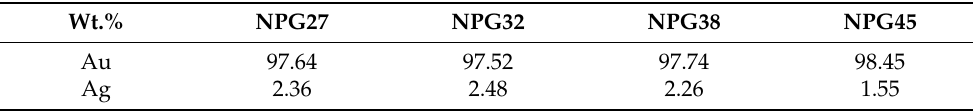
Table 1. Component analysis through EDX